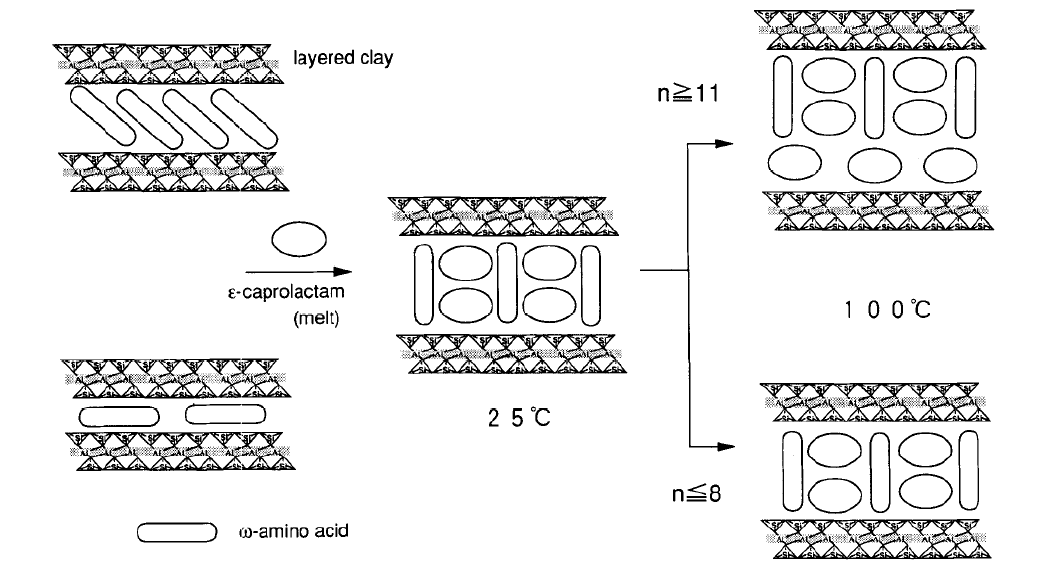
Figure 16. Intercalation of the modified montmorillonite with caprolactam. Reproduced from reference [70] with permission from